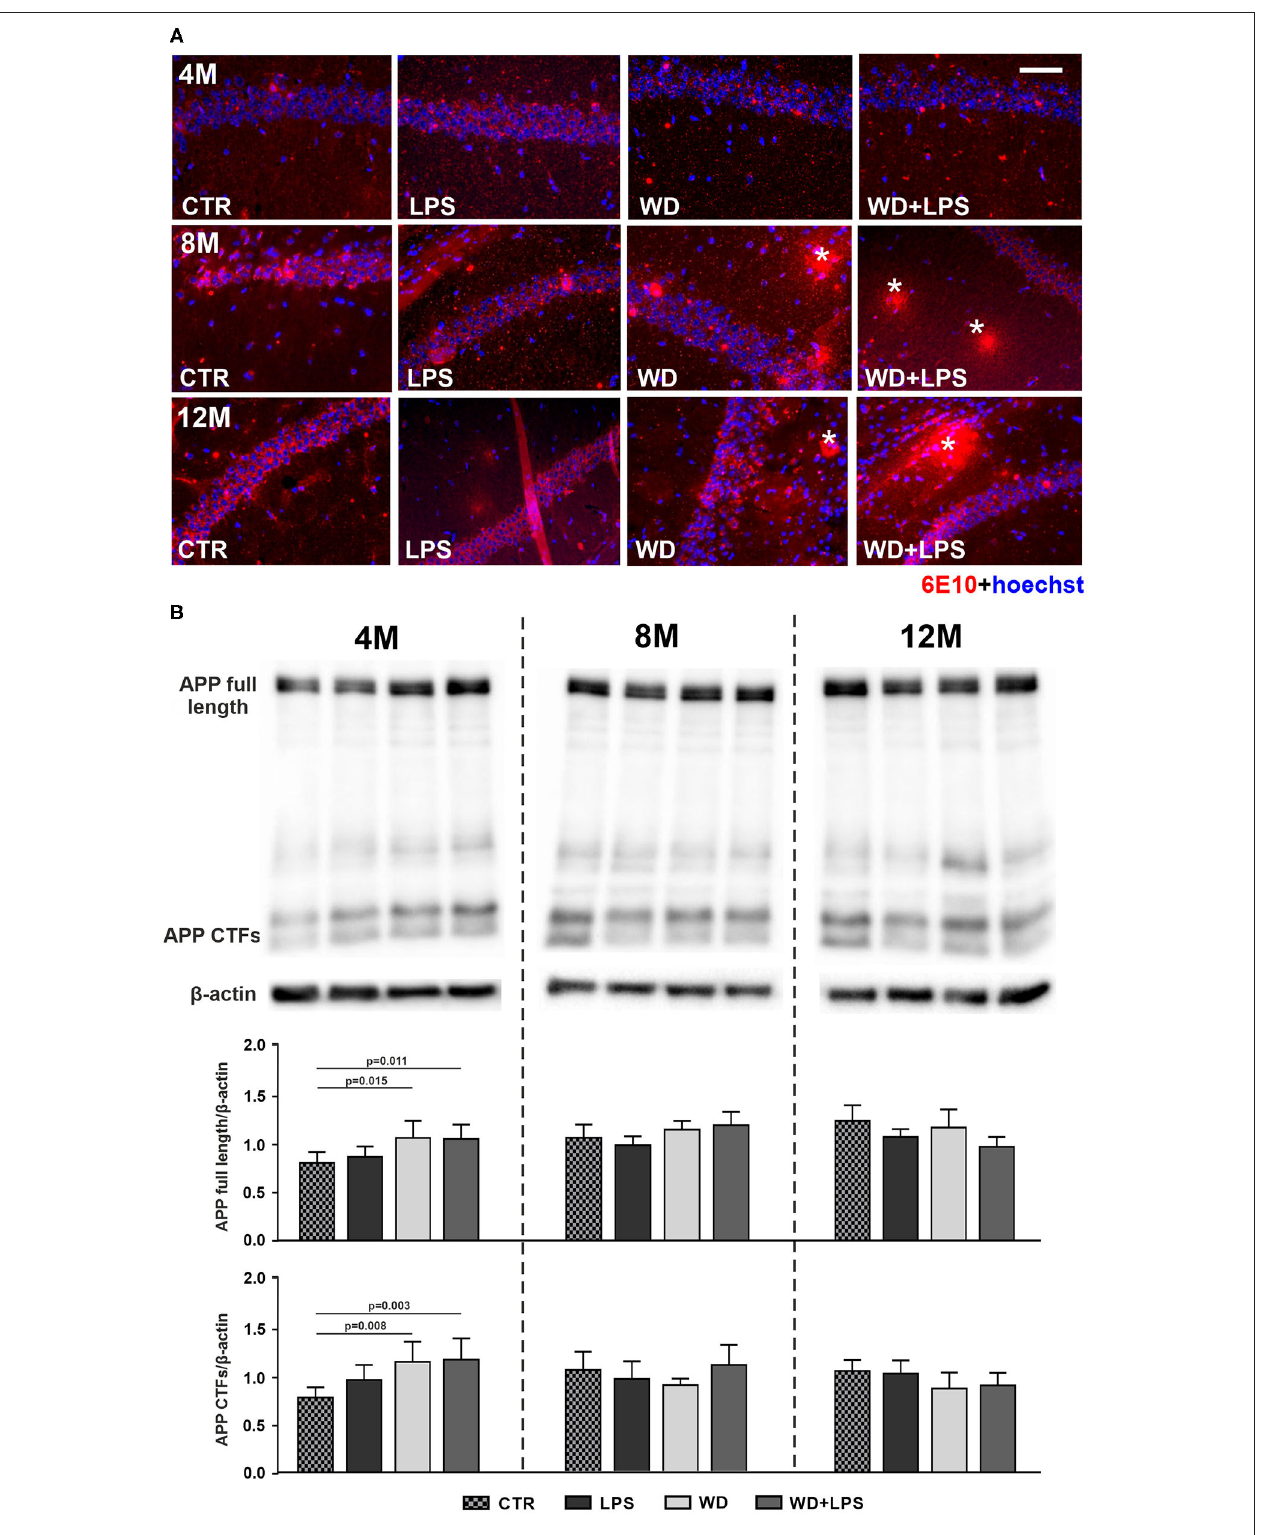
FIGURE 6 | Western diet accelerates deposition of amyloid- β plaques and APP accumulation in the hippocampus. (A) Comparative immunofluorescence images of brain hippocampal tissue from 4-, 8-, and 12-month-old APPswe mice probed with anti-A β antibody 6E10 show accelerated formation of A β plaques (*) in